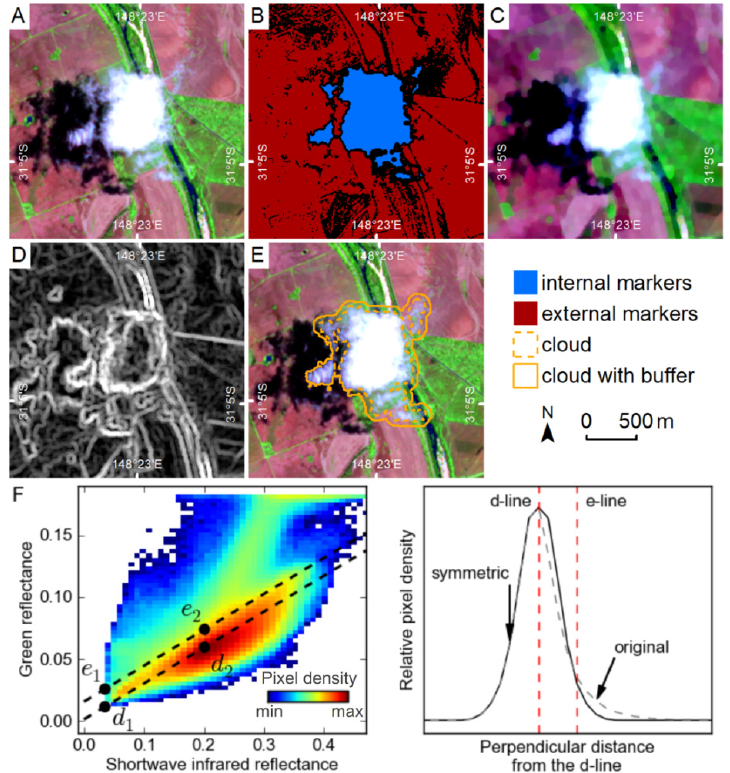
Figure 8. An example of how SPOTCASM generates cloud segments. ( A ) A subset of image 3 shown with bands 4, 3, 1 as red, green and blue; ( B ) Internal and external markers; ( C ) An alternating sequential filter (ASF) is applied to the image to smooth within object variation while enhancing object edges; ( D ) The sum of the morphological gradient of each band after the ASF was applied enhances object edges, shown as greyscale where white is high and black is low; ( E ) Cloud objects are grown using the watershed from markers algorithm, before a five pixel buffer is applied; ( F ) Thresholds for marker pixels are identified on the 2-dimensional histogram of bands 1 (green) and band 4 (SWIR). The density values along a line perpendicular to the d-line, going through point d define the offset to the